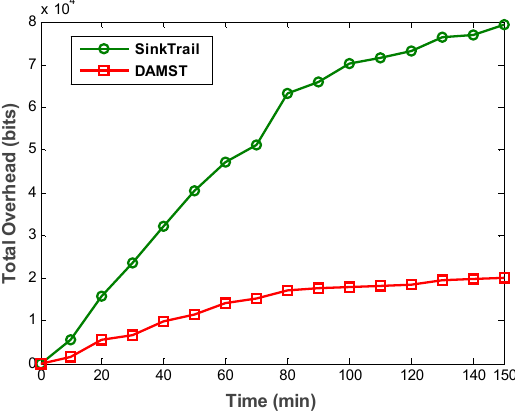
Figure 16. Total overhead in DAMST and SinkTrail.